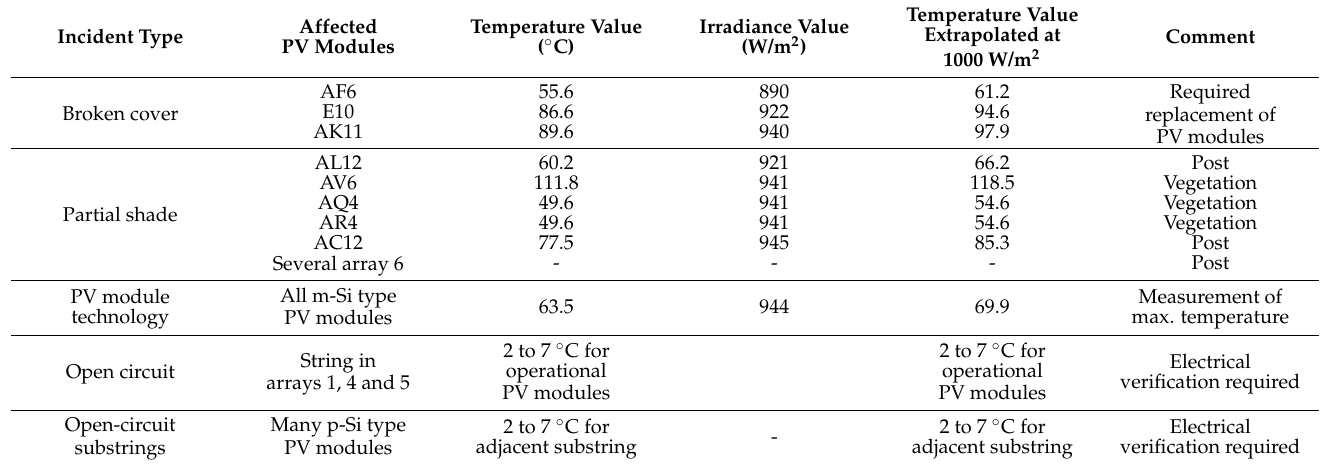
Table 1. Summary of incidents detected during